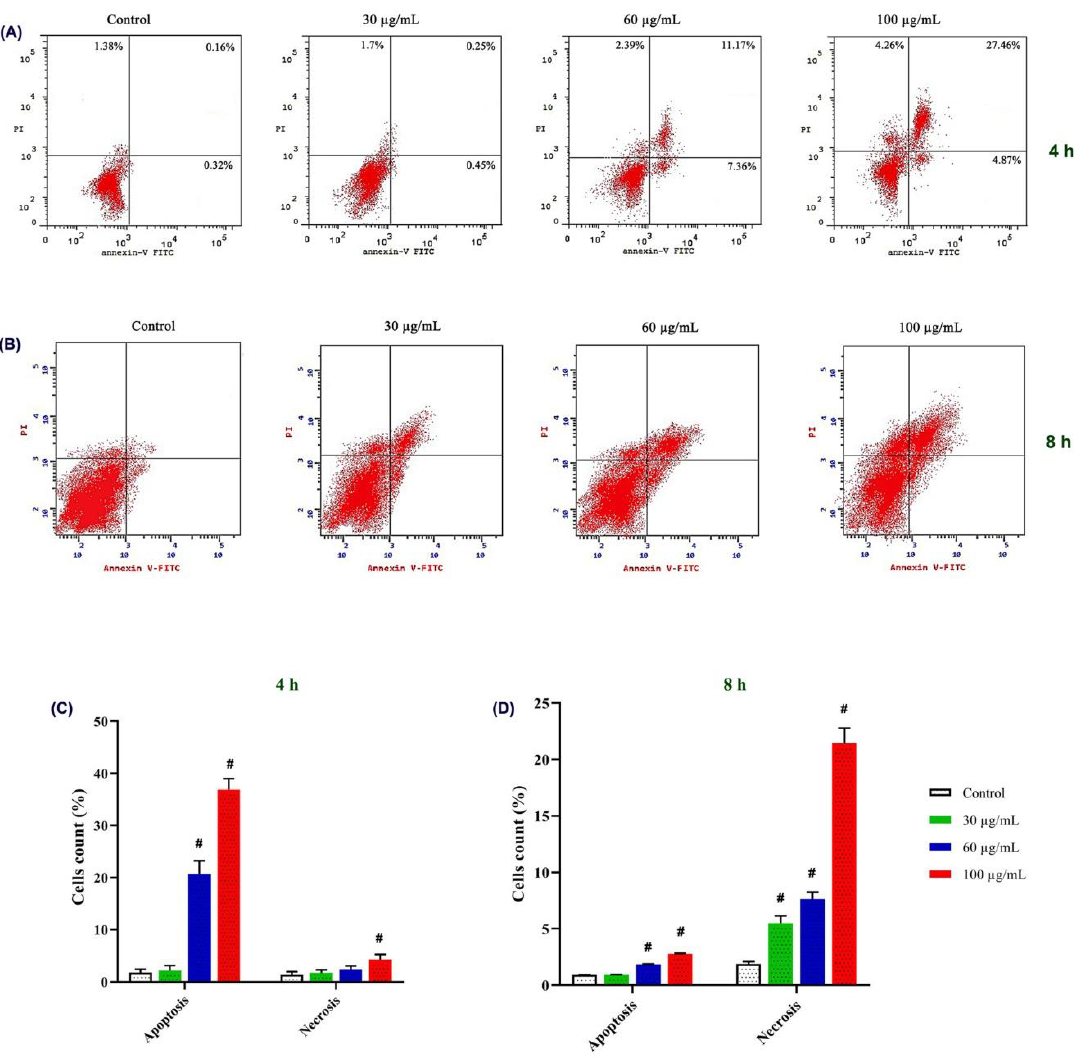
Figure 5. Effect of different M. domestica hemolymph concentrations, 4 h ( A ) and 8 h ( B ) post-curcumin injection, on the incidence of apoptosis/necrosis in treated and control MCF-7 cells. The flow cytometric dot-plot was analyzed after annexinV/propidium iodide (PI) labeling, 4 h ( C ) and 8 h ( D ). Data were illustrated as mean ± SD ( n = 3). # shows the significant increase ( p < 0.05).